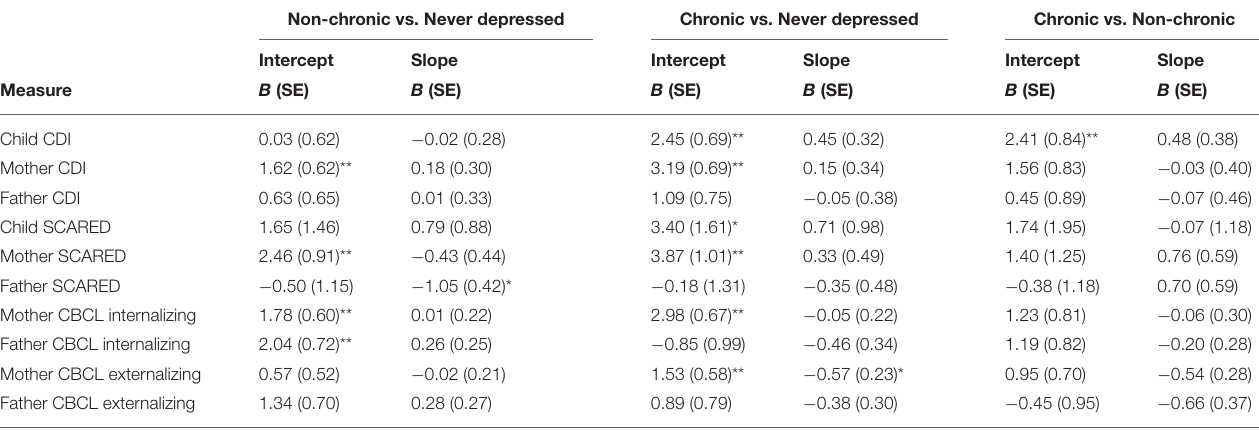
TABLE 2 | Multi-level models using maternal depression at age 3 to predict symptom outcomes across subsequent waves using the DSM approach. Non-chronic vs. Never depressed Chronic vs. Never depressed Chronic vs. Non-chronic Intercept